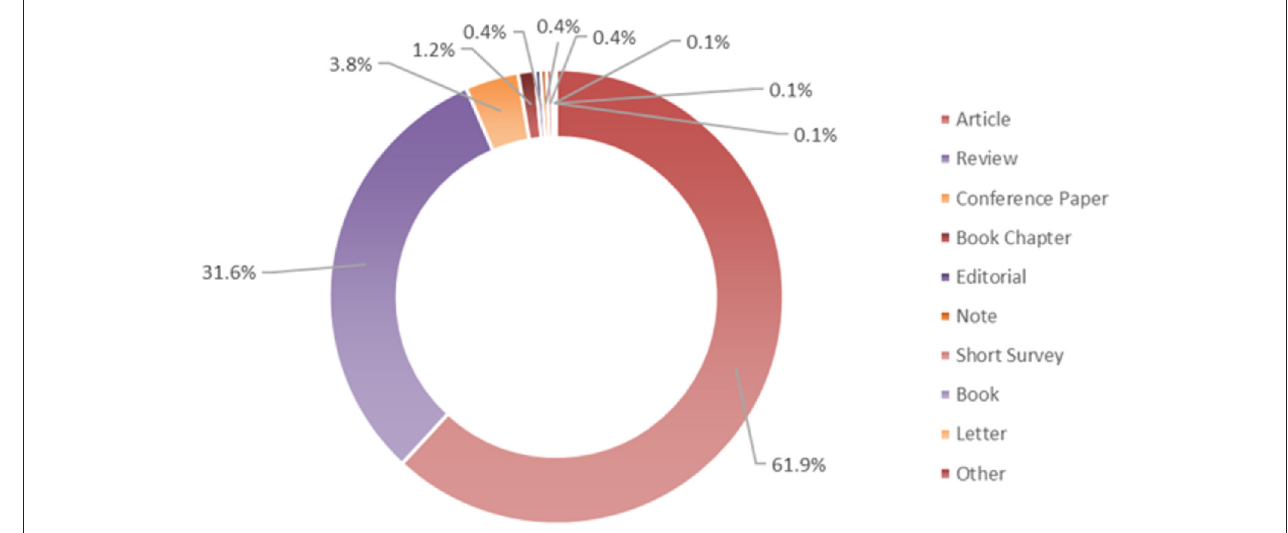
FIGURE 1 | Distribution of documents by type. Based on data from Scopus.